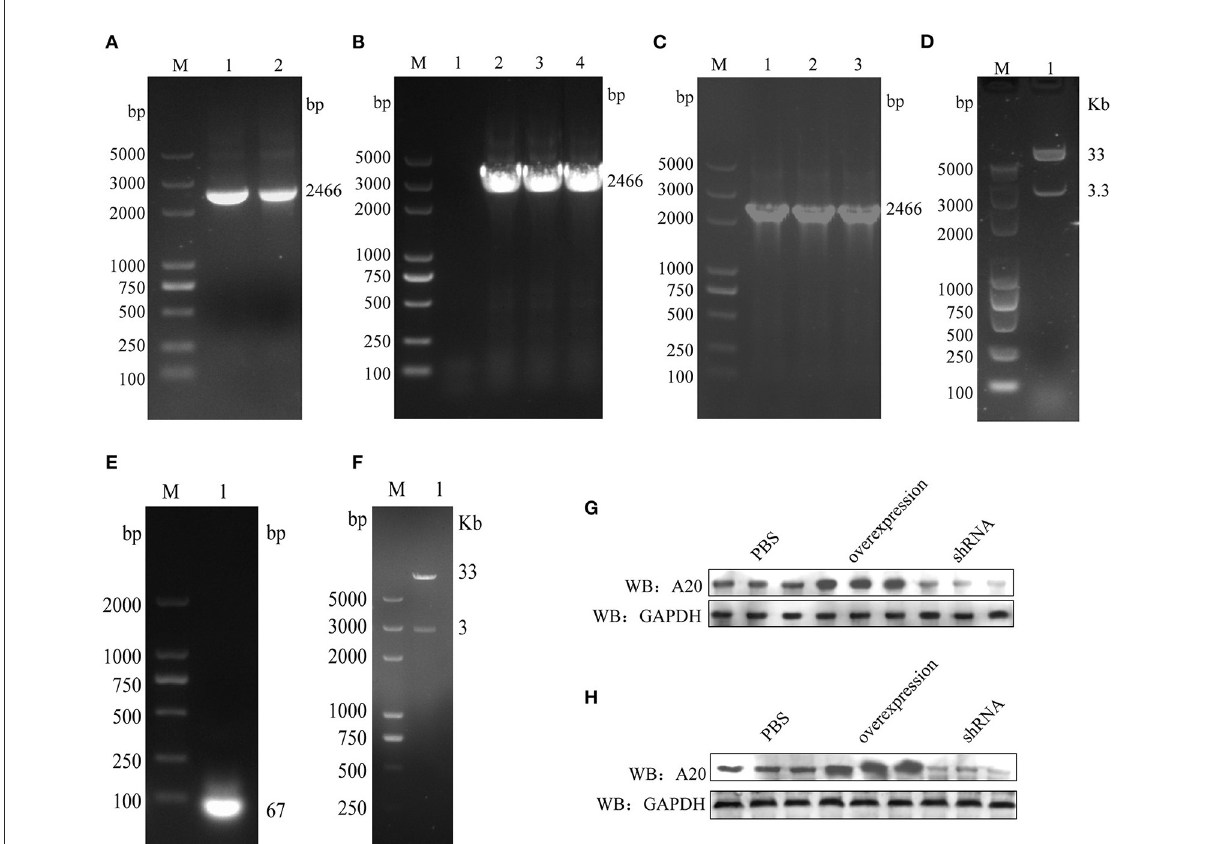
FIGURE2 Constructing A20 recombinant adenovirus. (A) A20 gene amplification. (B) Identifying pshuttle-IRES-hrGFP2-A20 positive colonies. (C) Identifying Ad-pshuttle-IRES-hrGFP2-A20 positive colonies. (D) The plasmid Ad-pshuttle-IRES-hrGFP2-A20 has been digested with restriction endonuclease PacI. (E) A20 single-stranded shRNA anneals to double-stranded. (F) The plasmid Ad-pshuttle-H1-A20 shRNA is digested with restriction endonuclease PacI. (G) The effect of A20 adenovirus in the chicken embryo kidney. (H) The effect of A20 adenovirus in the chicken embryo